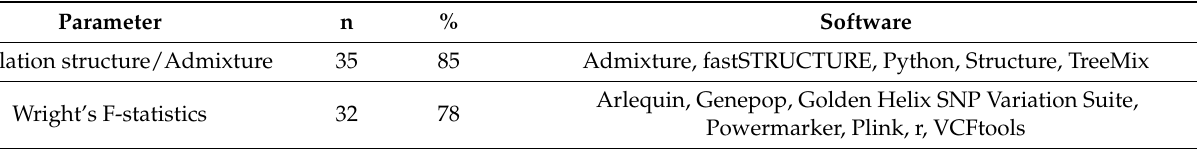
Table 2. Number and percentage of publications reporting different type of diversity parameters, estimated with microsatellites based on 68 studies and software used. Table from Olschewsky et al., 2021